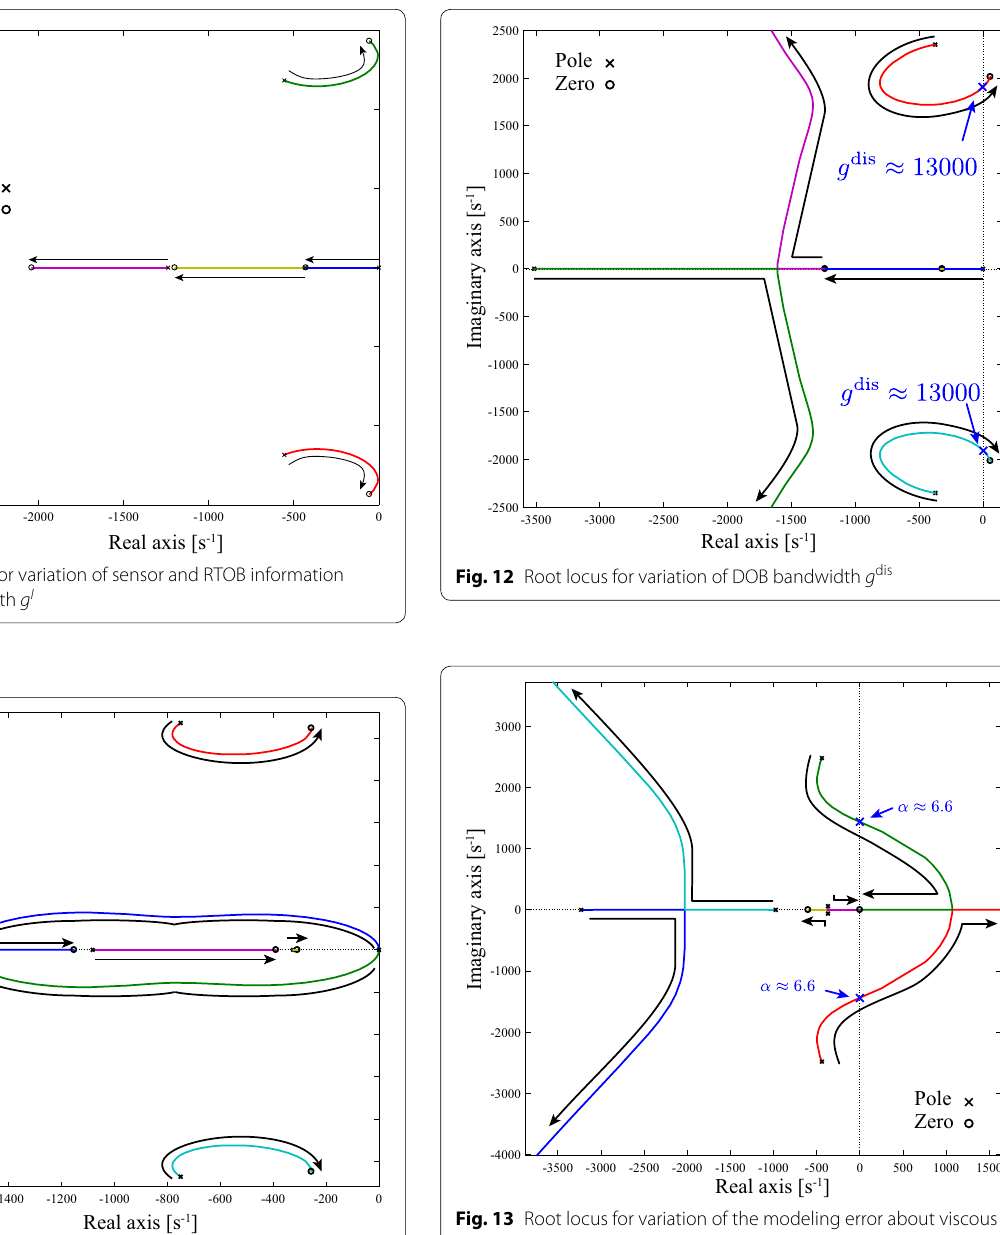
Fig. 11 Root locus for variation of sensor and RTOB bandwidth g ext